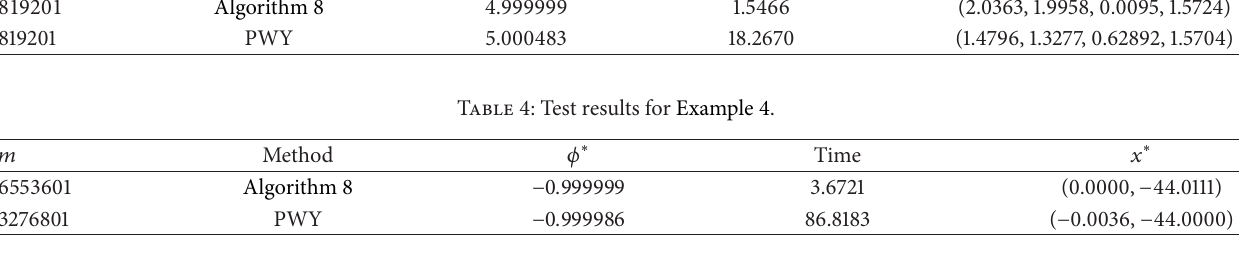
Table 5: Test results for Example